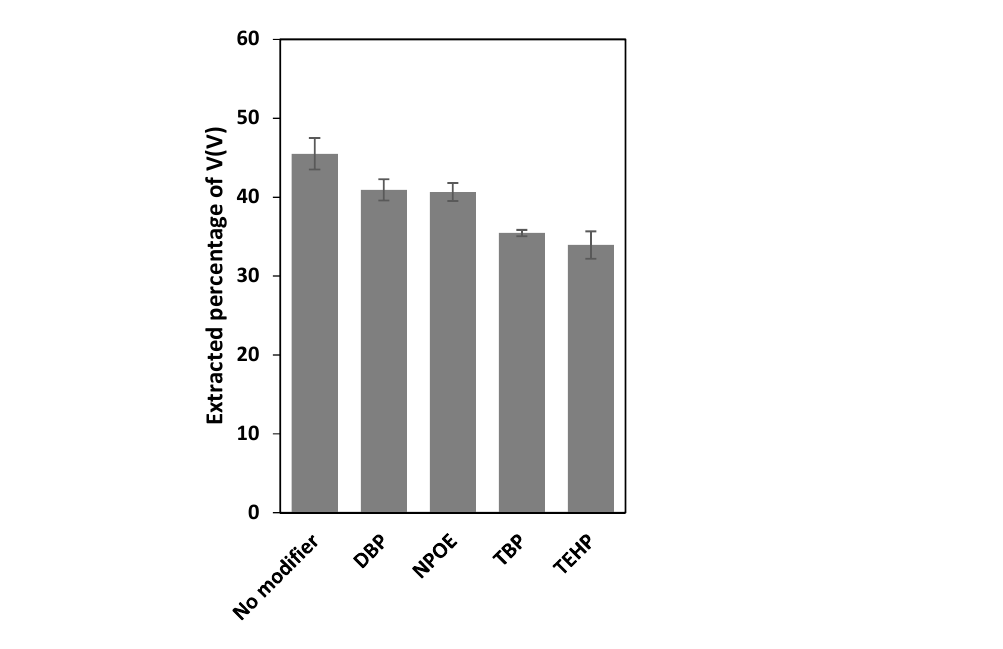
Table 1. Comparison of the extraction percentages of the successful PIMs a .